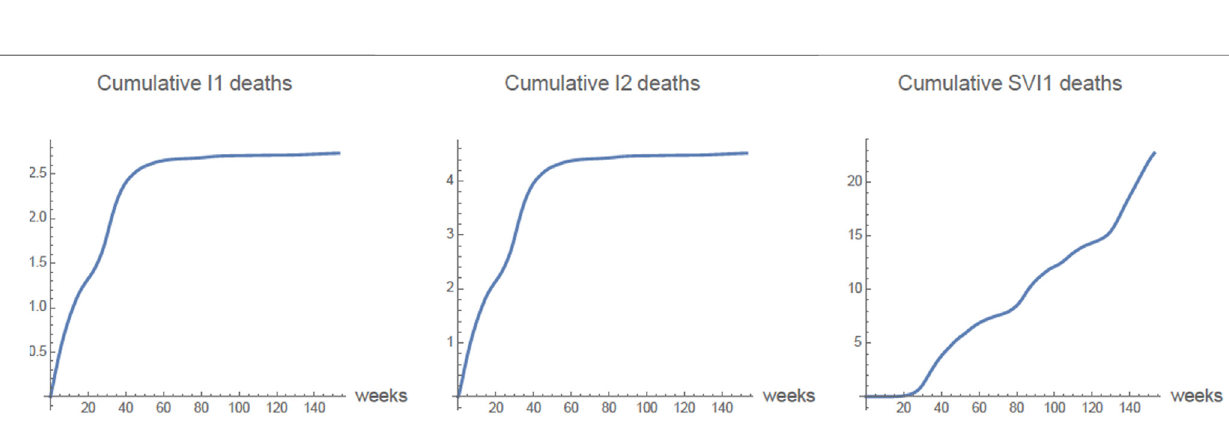
In Figure 6 the graph of the cumulative number of all deaths each week of the 875,000 vaccinated 9 years olds is given. The number of all deaths in 2016, 2017, 2018 is ≈ 30. From the